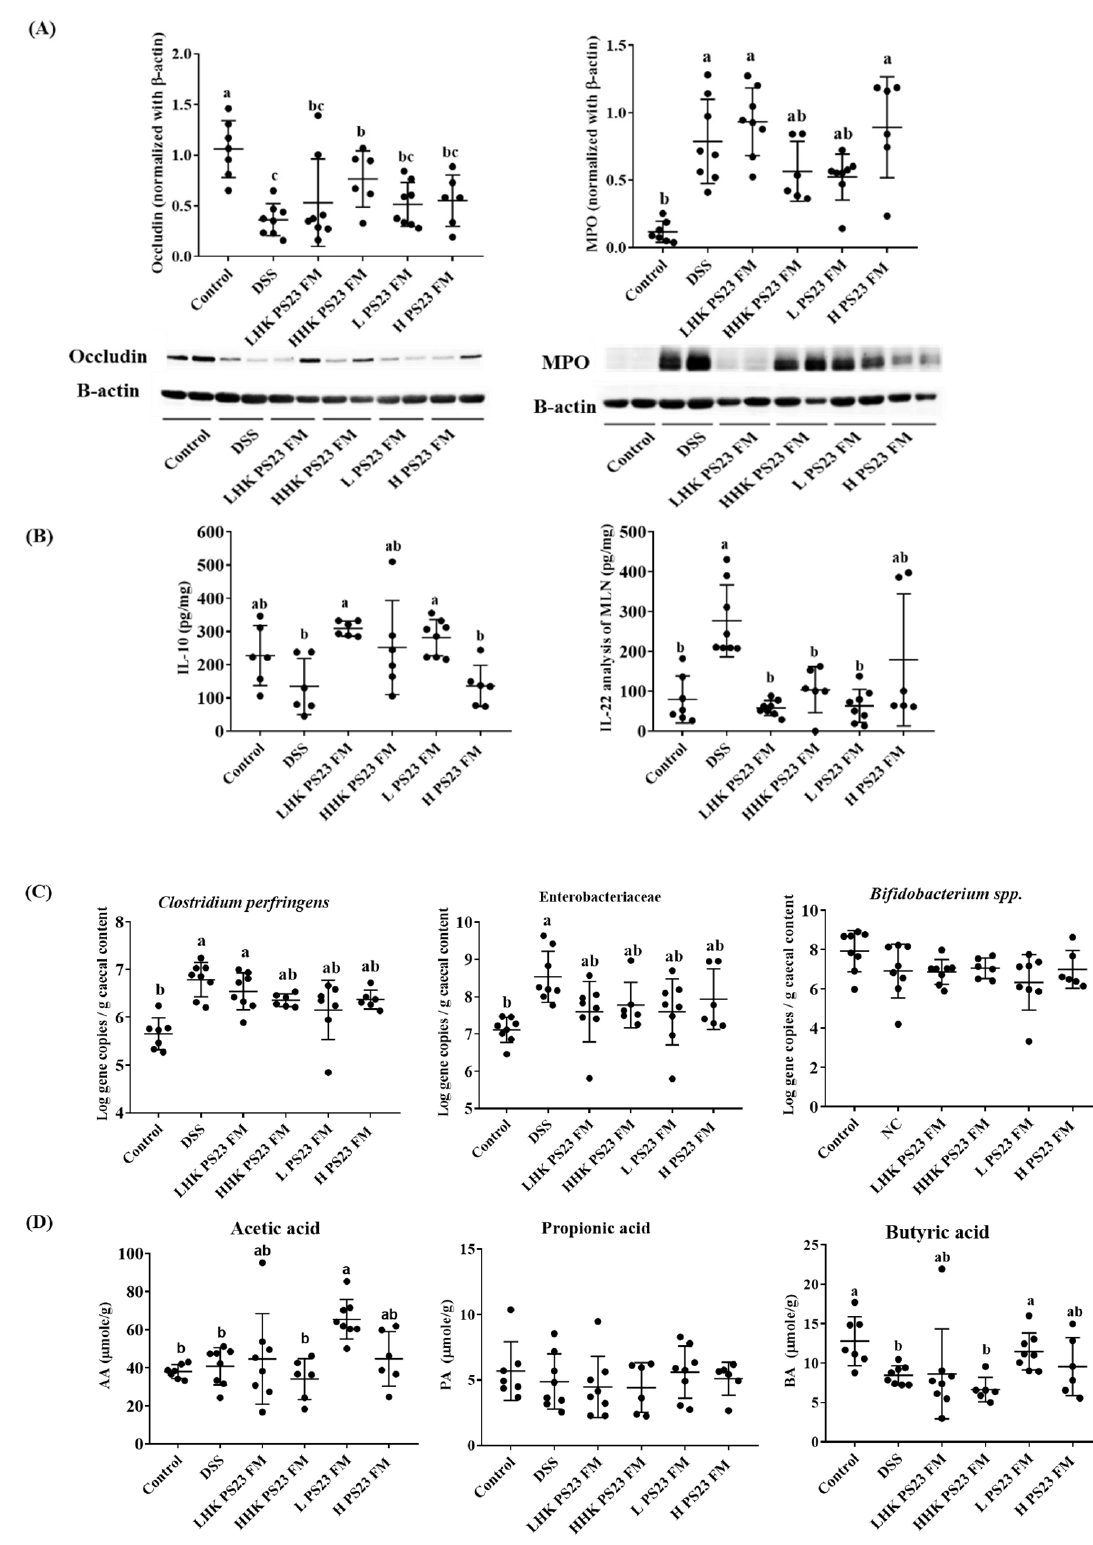
Figure 5. Effect of PS23-fermented milk on ( A ) tight junction protein expression in the large intestine, ( B ) cytokines in mesenteric lymph nodes (MLN), ( C ) cecal luminal bacteria, and ( D ) cecal short chain fatty acid in DSS-induced colitis mouse model. Data are expressed as means ± SD ( n = 6–8). Statistical analysis was performed using analysis of variance with the Tukey test. Different letters indicate a significant difference p < 0.05. LPS23 FM: low-dose L. paracasei PS23 with yogurt culture fermented milk (10 7 CFU/mouse); LHK PS23 FM: heat-killed LPS23 FM; HPS23 FM: high-dose L. paracasei PS23 with yogurt culture fermented milk (10 8 CFU/mouse); HHK PS23 FM: heat-killed HPS23 FM. SD: standard deviation.